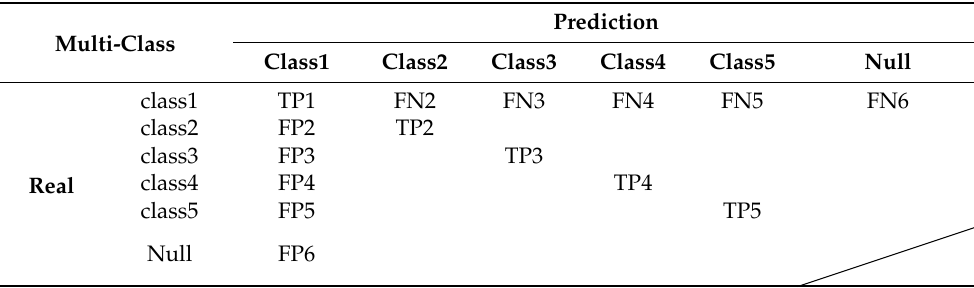
Table 3. Examples of five-classification precision and recall. TP (true positive), FP (false positive), and FN (false negative). In particular, when the real target is class1, but the prediction result is empty, we are defined as FN6. When there is no real target, but the prediction result is class1, we define it as FP6.